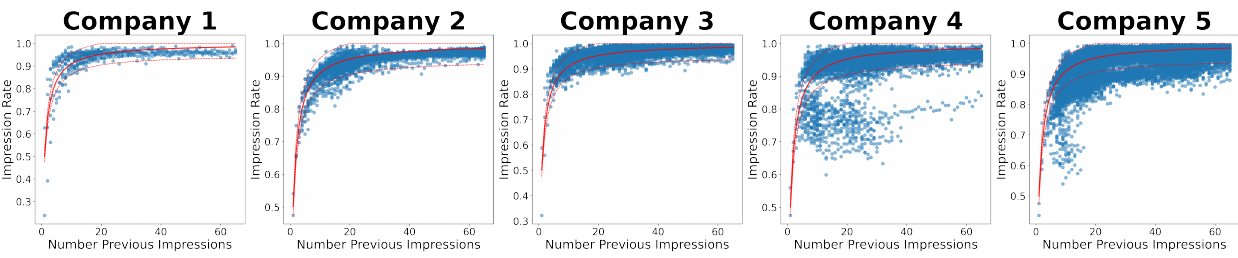
Figure 3. In the figure, we can see data for the five clients. There are points for the Impression Rates based on the number of previous impressions (for states with 100 users or more). On top of the IR is to draw the function lines one over and other below with a 5%